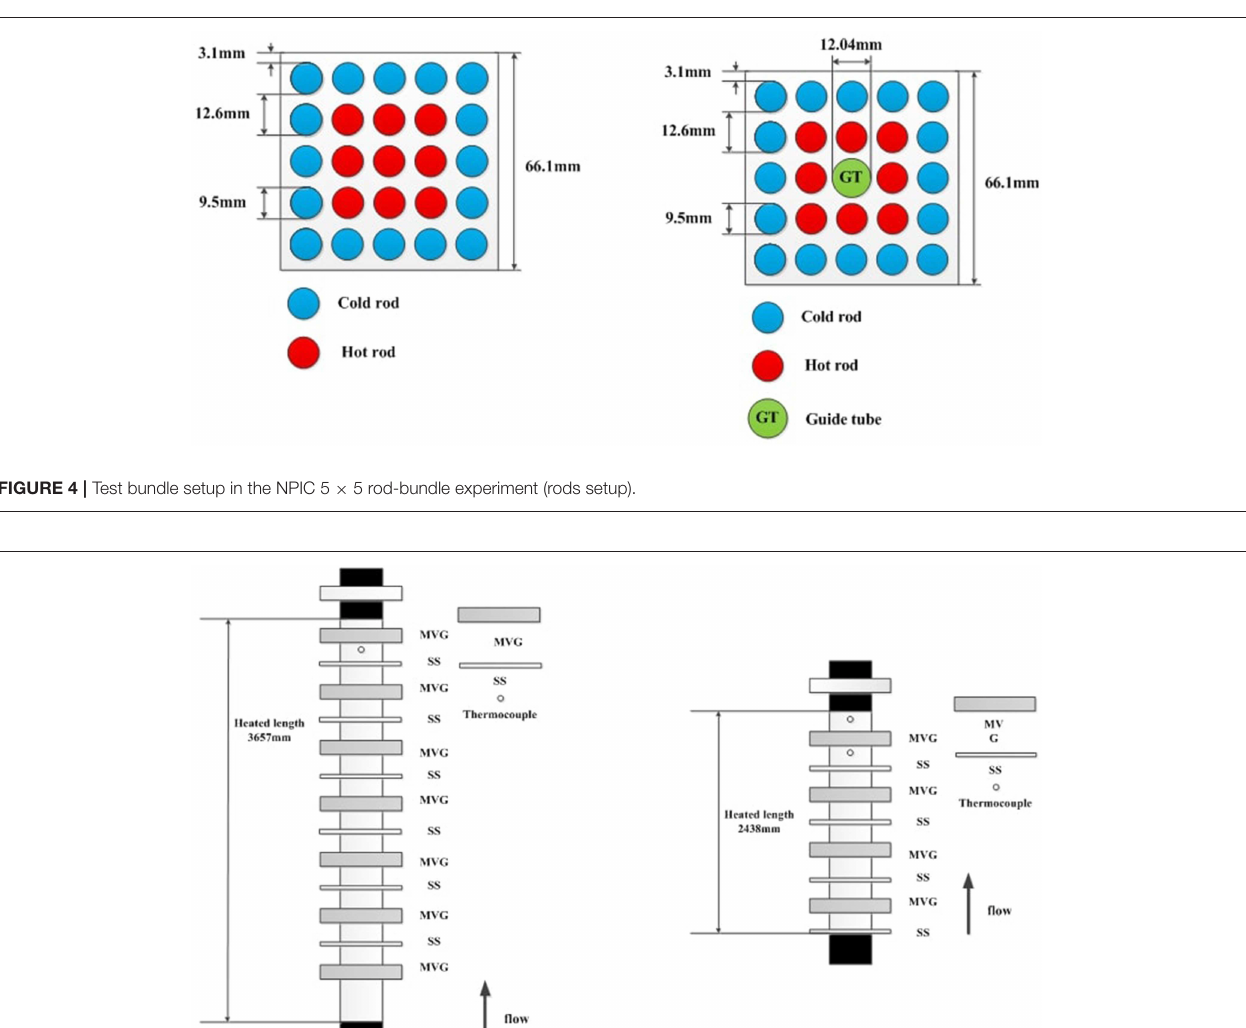
Frontiers in Energy Research |